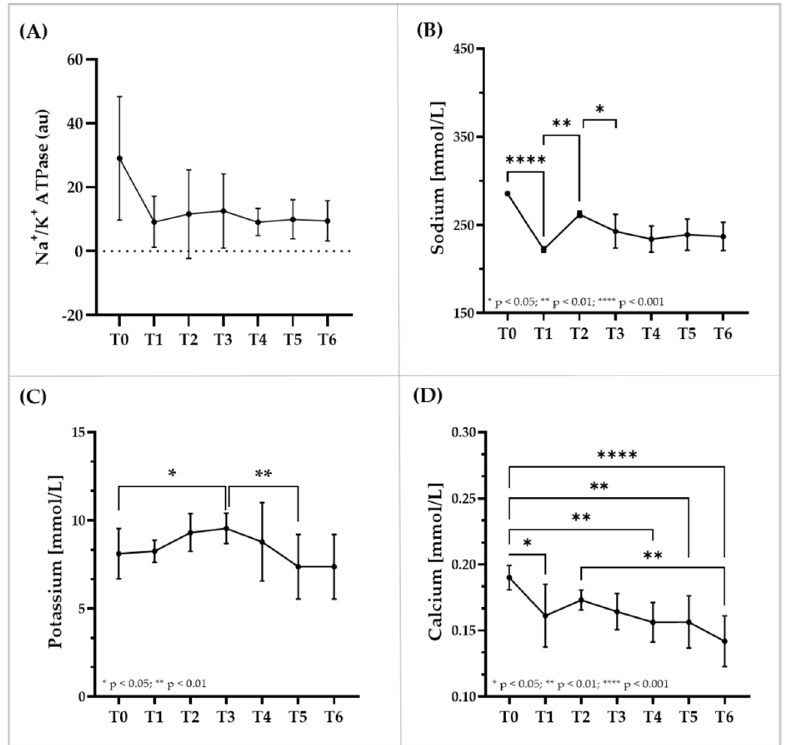
Figure 6. RBC Na + /K + − ATPase and changes in RBC electrolyte concentrations during blood sampling and transfusion. ( A ) Staining of Na + /K + − ATPase remained unaffected by the intervention. ( B ) RBC sodium levels decreased after first blood sampling and after transfusion. ( C ) RBC potassium levels increased during sampling phase and decreased during transfusion phase. ( D ) RBC calcium levels decreased throughout the study period. Data are mean (SD).